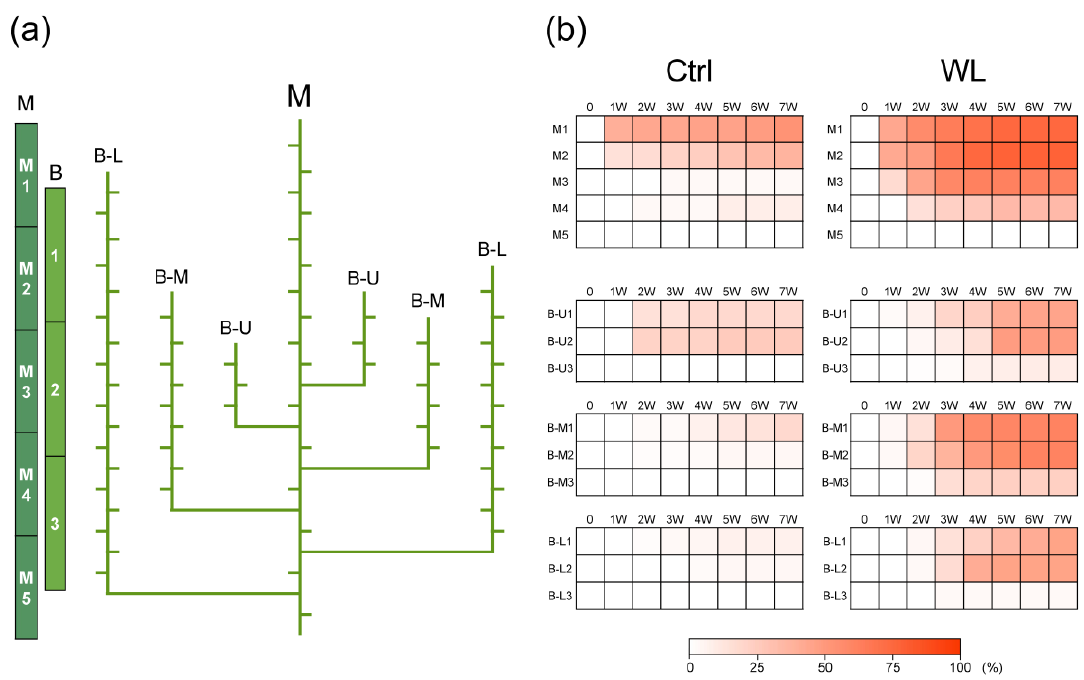
Figure 2. Comparison of spatiotemporal bulbil formation between control (Ctrl) and waterlogged (WL) soil conditions. ( a ) Classification of leaf axil positions. The main stem (M) was divided into five parts (M1 to M5). The branch stems (B) were separated into three positions (upper: U; middle: M; lower: L) and divided into three parts (1 to 3). ( b ) The heat map represents weekly changes in percentage of formed bulbils in all leaf axils at each part. The data are the means of seven replications derived from different plants.